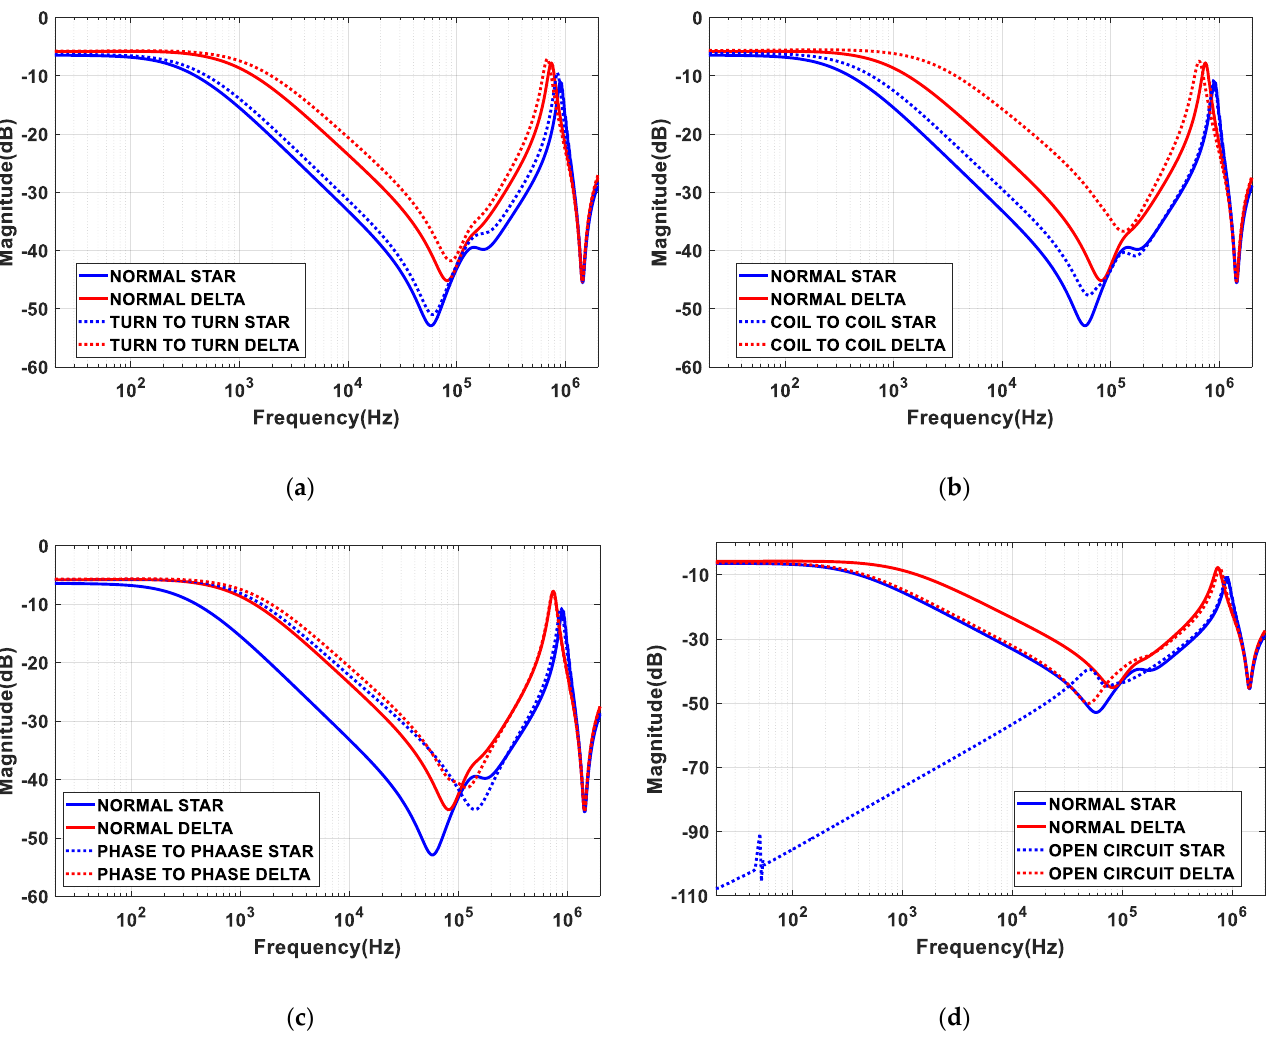
Figure 4. FRA measured responses for star vs. delta 3 HP IM at ( a ) Normal vs. Turn-to-Turn, ( b ) Normal vs. Coil-to-Coil, ( c ) Normal vs. Phase-to-Phase SC fault and ( d ) Normal vs. open circuit.